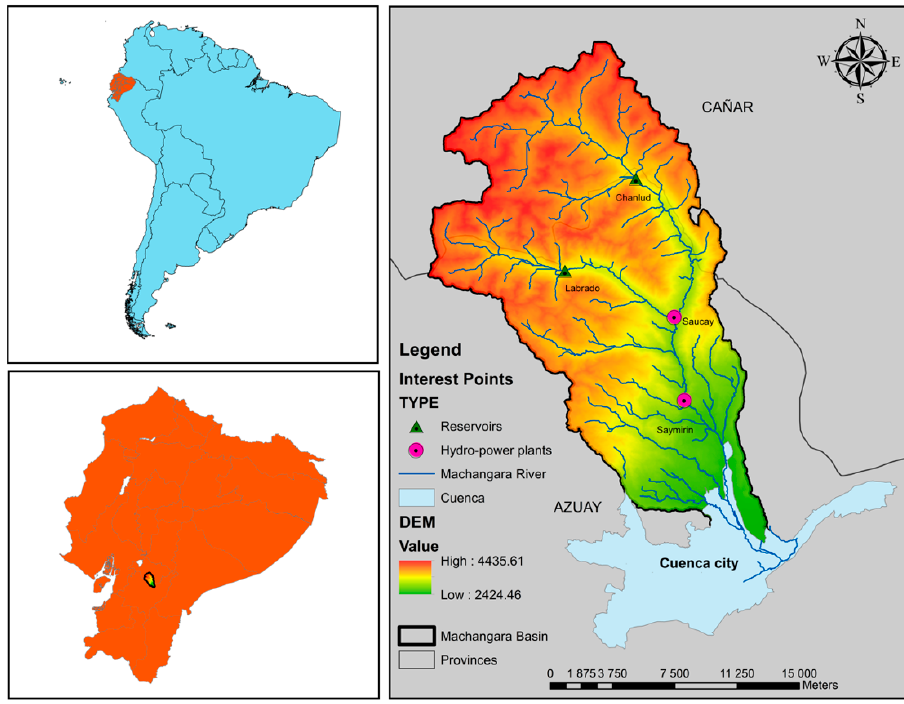
Figure 1. The Mach á ngara River Basin in Ecuador. Figure 1. The Machángara River Basin in Ecuador.